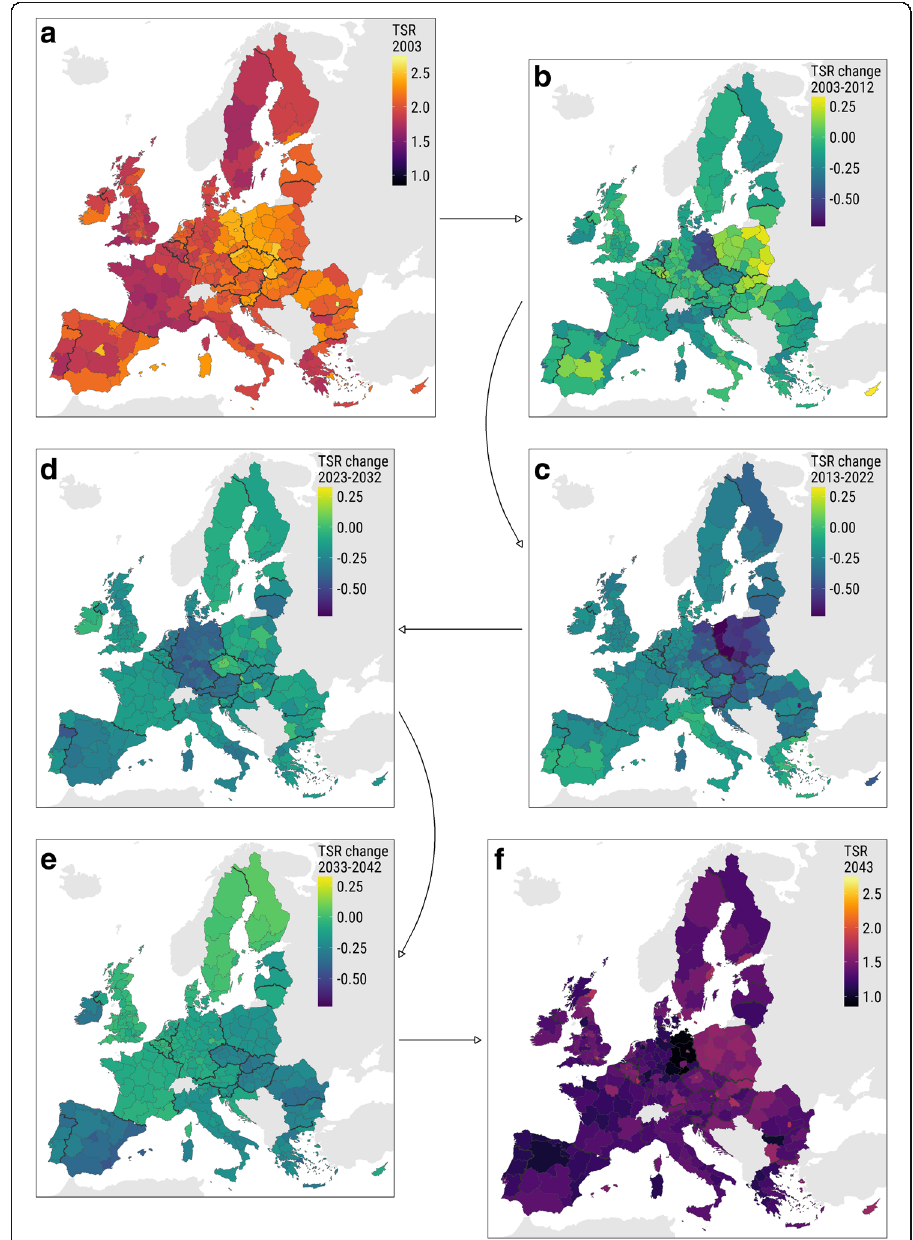
Fig. 1 Total support ratio dynamics in the four decades between 2003 and 2043. Notes : a TSR in 2003. b TSR growth during the observed period, 2003 – 2012. c – e TSR growth in the three decades of the projected period, 2013 – 2022, 2023 – 2032, and 2033 – 2042, correspondingly. f TSR in 2043. Color scales are fixed for better comparison: (1) in maps a and f and (2) in maps b , c , d , and